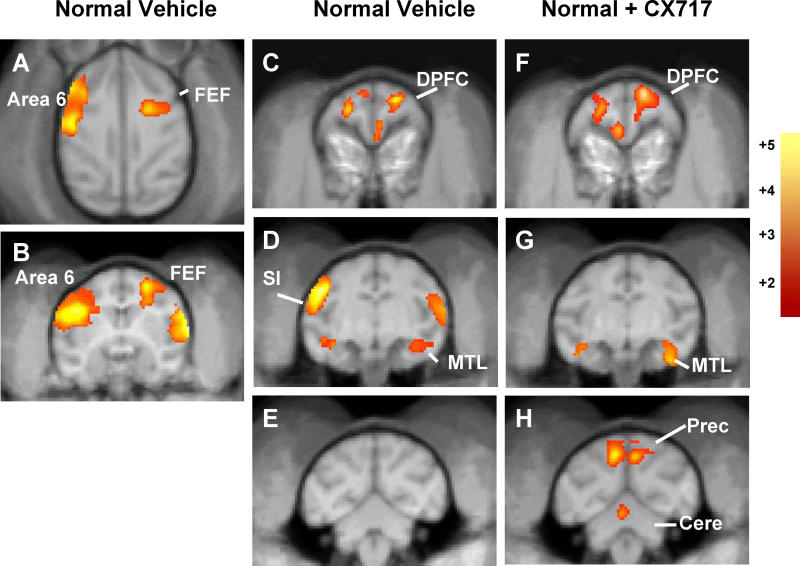
SPM Maps of Brain Regions Showing Changes in Regional CMRglc during Performance of DMS Task for Normal Vehicle and Normal + CX717 Conditions(A–E) Maps are shown for the comparison of CMRglc during DMS performance in the normal vehicle to the baseline, no-task condition. CMRglc was significantly increased during normal vehicle condition compared to baseline, no-task condition.(F–H) Maps are shown for the comparison of CMRglc during DMS performance in the normal + CX717 condition to normal vehicle condition. CMRglc was increased following the administration of CX717 (0.8 mg/kg, IV) as compared to normal vehicle condition (C–E).Regional changes are displayed on both horizontal section (A) and coronal sections (B–H) of MR images of rhesus monkey brain at the level of the motor and premotor cortex (A and B), DPFC (C and F), MTL (D and G), and parietal cortex (E and H). Statistical parametric maps were generated using SPM99 software. Colors indicate the location of clusters with a height (magnitude) threshold of p < 0.05 and spatial extent greater than 50 voxels. Color bar indicates t values for the comparisons (red, t = 2.0, p < 0.05; yellow, t = 5.0, p < 0.001). Note: left and right half of hemisphere are shown on left and right of images respectively. Area 6, premotor cortex; Cere, cerebellum; FEF, frontal eye fields; Prec, precuneus; S1, primary somatosensory cortex.DOI: 10.1371/journal.pbio.0030299g007